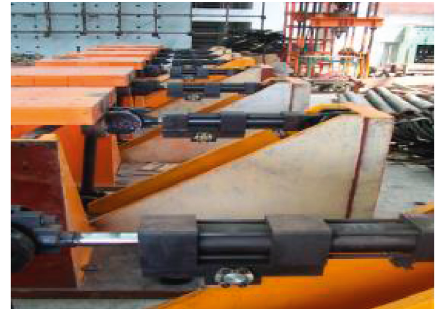
Figure 5: 1m × 1 m 9-table seismic array of